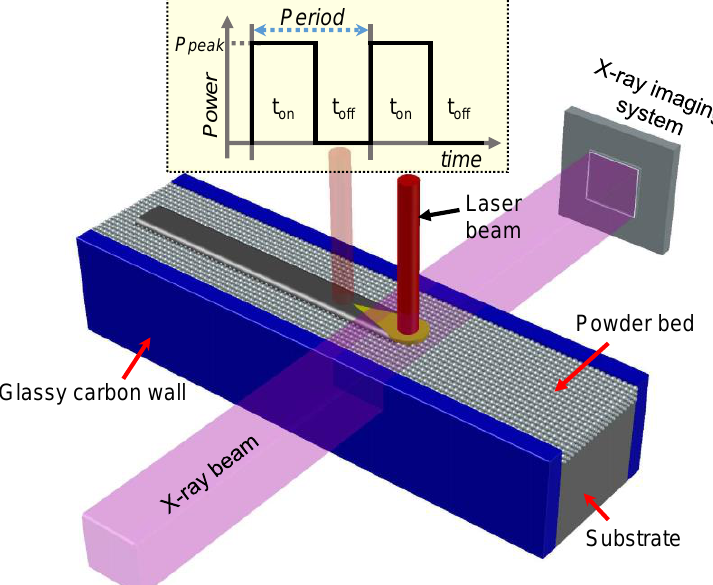
Figure 1. Schematic of the x-ray imaging experiment and the temporal characteristics of the PW-LPBF (pulsed wave laser powder bed fusion) process. The figure shows the temporal characteristic of square shaped pulses used in the experiment and the definition of laser on and off periods. Note that the actual output of the pulse shape may deviate from the perfect square shape specified in the laser control program.